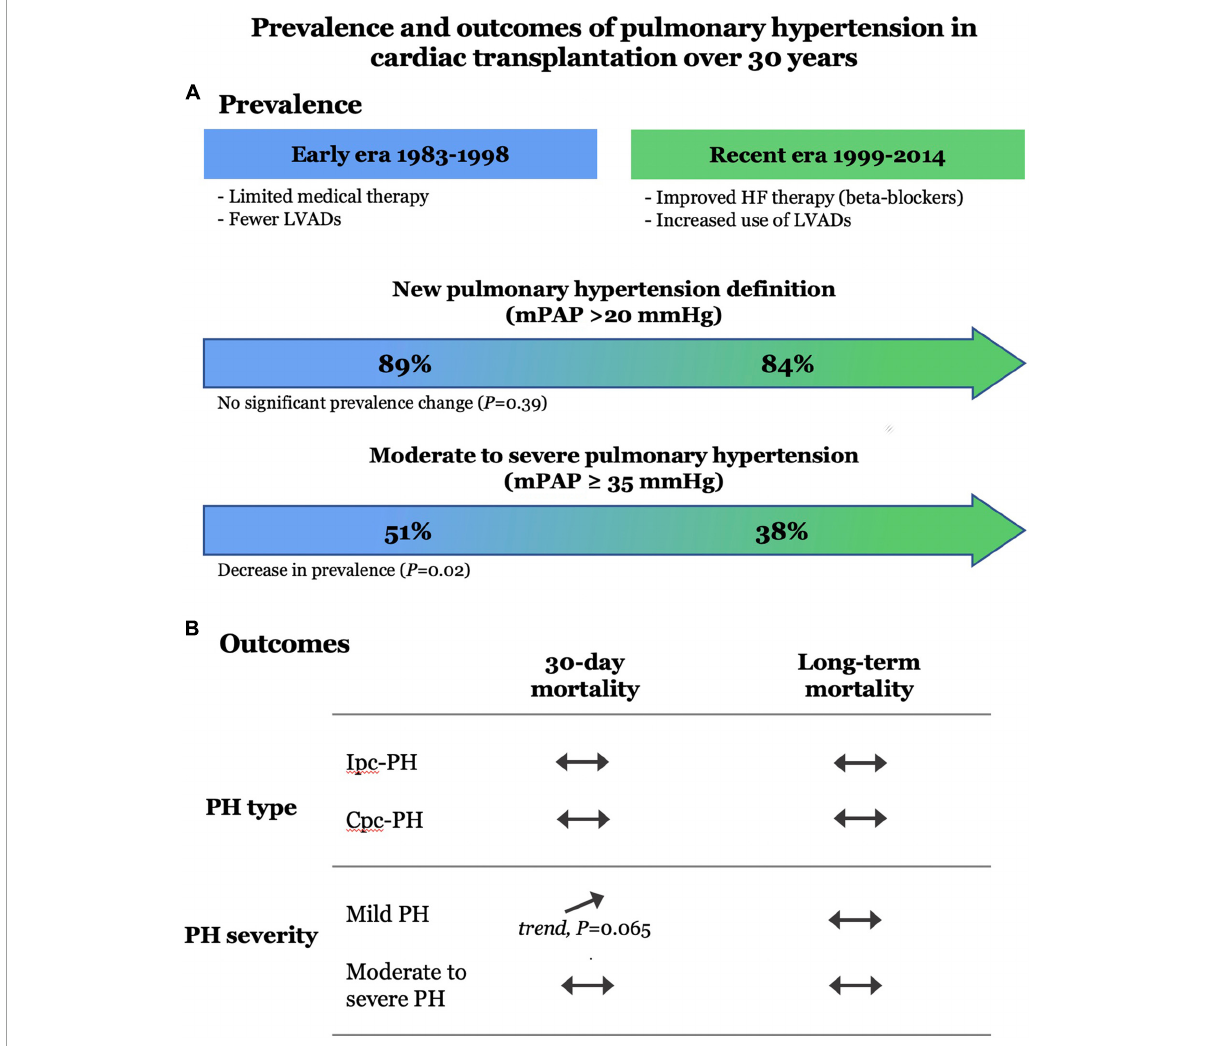
GRAPHICALABSTRACT Prevalence and outcomes of group 2 PH in cardiac transplant recipients over 30